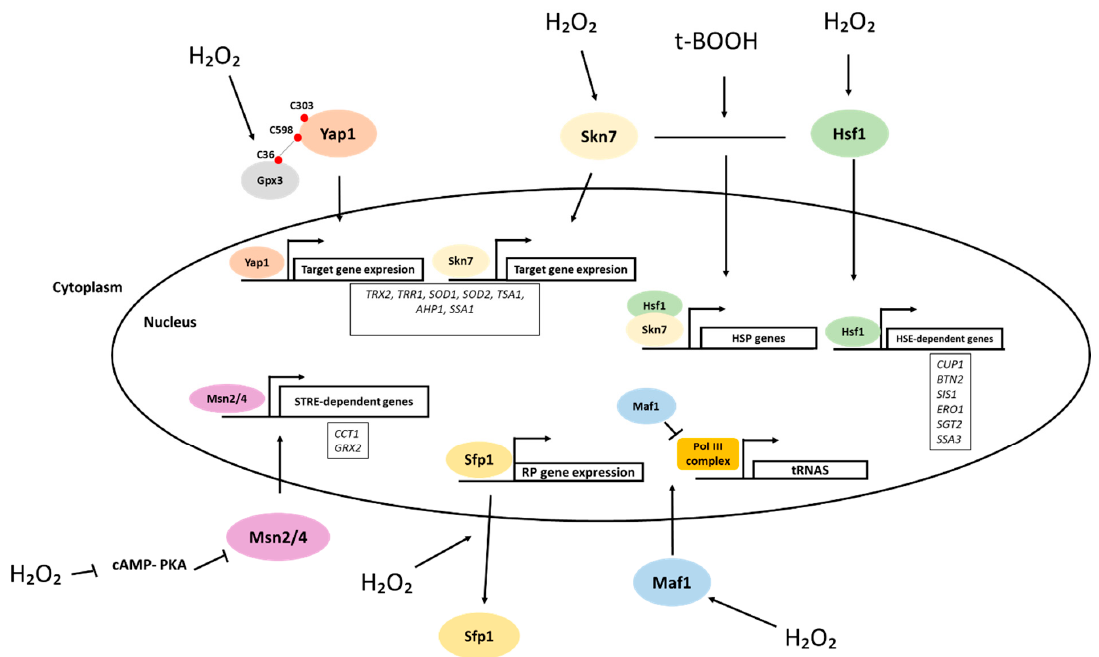
Figure 1. Impact of H 2 O 2 on transcription in yeast. Five different transcription factors respond to H 2 O 2 in yeast. Upon H 2 O 2 addition, Yap1 is retained in the nucleus where it stimulates the expression of target genes. Gpx3 is the H 2 O 2 sensor of Yap1 that uses its cysteine 36 to form a disulfide bond with the cysteine C598 of Yap1, eventually resolved into a Yap1 intramolecular disulfide bond (between C598 and C303) inhibiting nuclear export. Yap1 controls the expression of different genes most of which require the presence of Skn7 as well. Upon the addition of t-butyl hydrogen peroxide (t-BOOH), Hsf1 interacts with Skn7 to achieve maximal induction of several HSP genes. Msn2/4 sensing of H 2 O 2 is accomplished through PKA-dependent phosphorylation. Maf1 controls the availability of tRNAs under H 2 O 2 through binding to PolIII. Under H 2 O 2 conditions, Sfp1 is localized in the cytosol and RP gene expression is